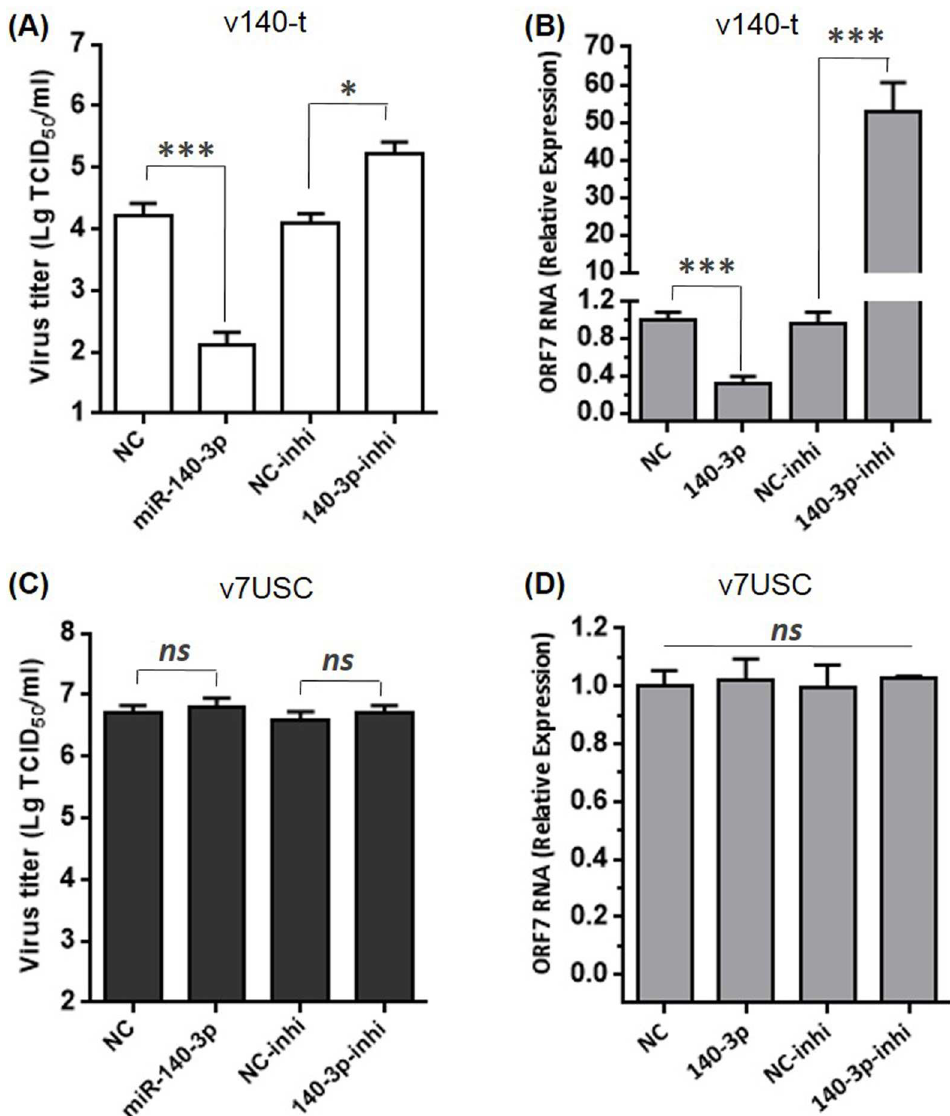
Fig 8. Over-expression of miR-140-3p inhibits the mutant v140-t but not wt virus. A and C: Confluent MARC-145 cells were transfected with the indicated miR-140-3p mimics, inhibitors, or NC. After 24 h, cells were infected with v140-t or v7USC (MOI = 0.05). The supernatants were collected at 36 h to determine viral titers. Virus titers were expressed as the lg TCID 50 /ml. B and D: qRT-PCR analysis of viral ORF7 RNA levels in MARC-145 cells transfected with miR-140-3p mimics, inhibitors, or NC, followed by v140-t or v7USC infection. The data were normalized to GAPDH expression. these spontaneous mutations, resulting in observation of different spontaneous mutations between the two experiments. The spontaneously mutated nucleotides CT15391-15392GG occurring in the 3 0 end of the insertion region (Fig 9A) were identical with those in mutant virus v140-t in experiment 1. Interestingly, analysis of v140-t revealed different spontaneous mutations preferentially located among 2–8 nucleotides near the 3 0 end of the insertion region and corresponding to the “seed region” of mml-miR-140 (Fig 9B), indicating the preference of virus escape from the endogenous miRNA suppressive pressure.